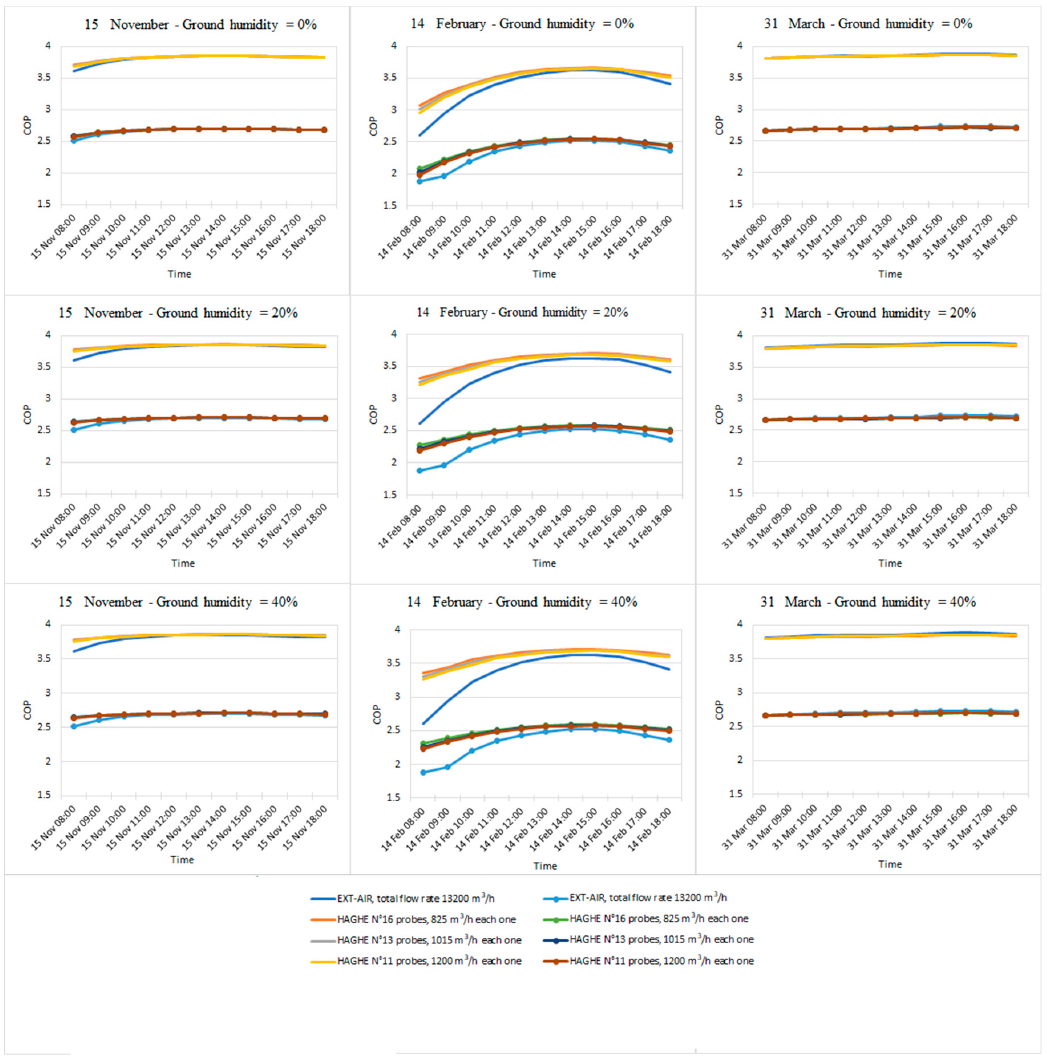
Figure 6. Hourly comparison between COP EXT-AIR and COP HAGHE by varying ground volumetric humidity, air flow rate and water temperature produced: L = 30 m, H = 3 m in 15 November, 14 February and 31 March. Table 5. Best values of COP (at T w = 35 °C), L = 30 m, H = 3 m, G = 833.33 m 3 /h. Ground Volumetric Humidity = 0%